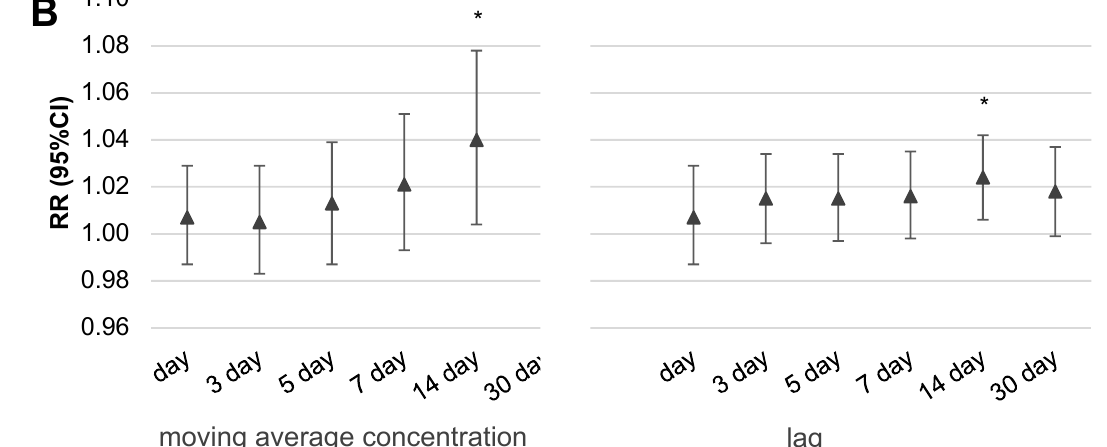
Figure 4. The risk ratio of daily outpatient visits ( A ) or hospitalizations ( B ) due to respiratory disorders related with the increase of PM 2.5 concentration by IQR value (22.5 µg/m 3 ) in two scenarios of exposure: expressed by the moving average concentration or related with a lag of health effect (RR was adjusted for season of the year, relative humidity, temperature, and atmospheric pressure; moreover, in the case of outpatient visits the model also included day of week; * indicates that a value is statistically significant). Legend: RR—risk ratio; CI—confidence interval; lag—temporal delay